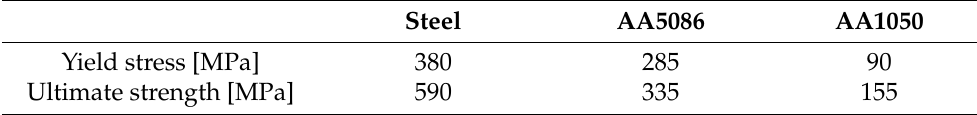
Table 3. Mechanical properties of the Al/Fe joints constituents, from Refs. [32,33].